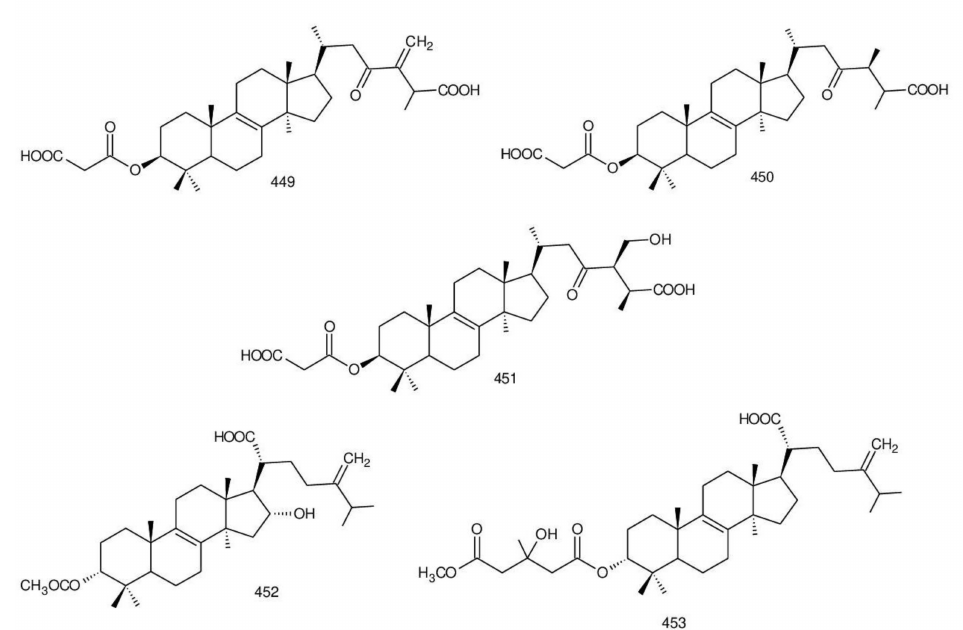
Figure 18. Chemical structures of several C31 triterpenoids ( 449 – 453 ).